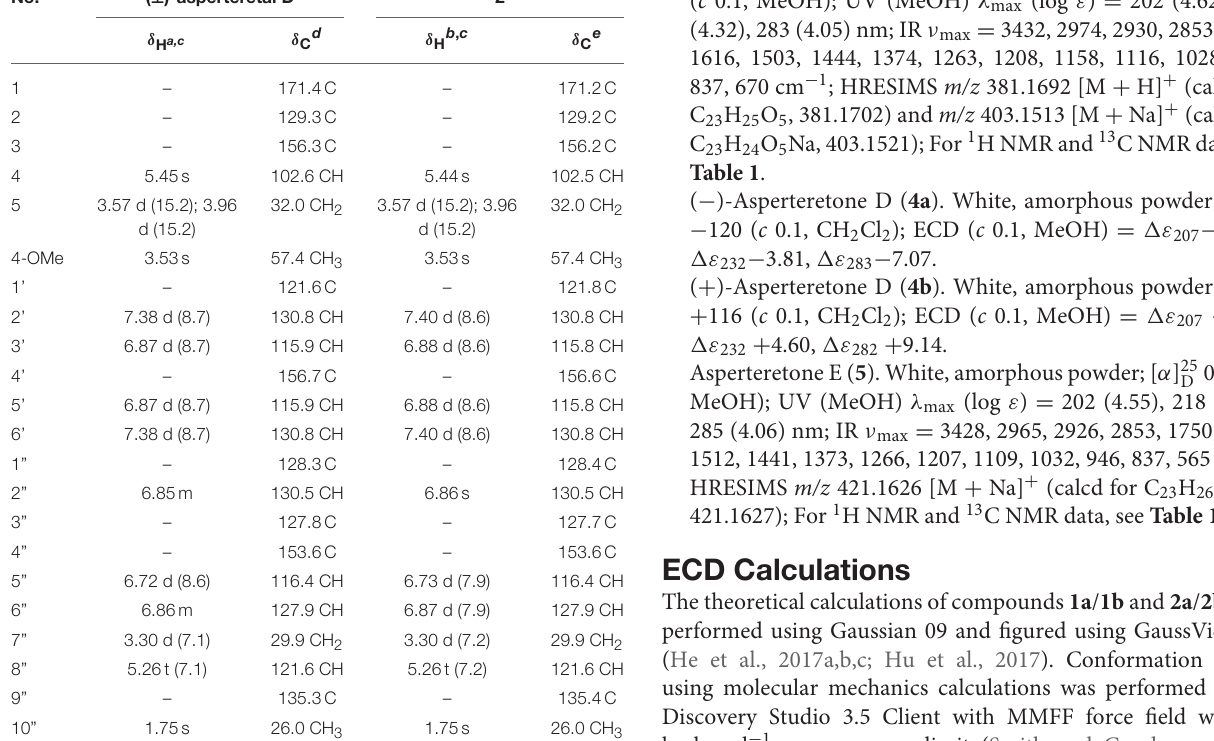
TABLE 2 | Comparison of the 1 H and 13 C NMR data for reported ( D and 2 in CDCl 3 ( δ in ppm and J in Hz). No.